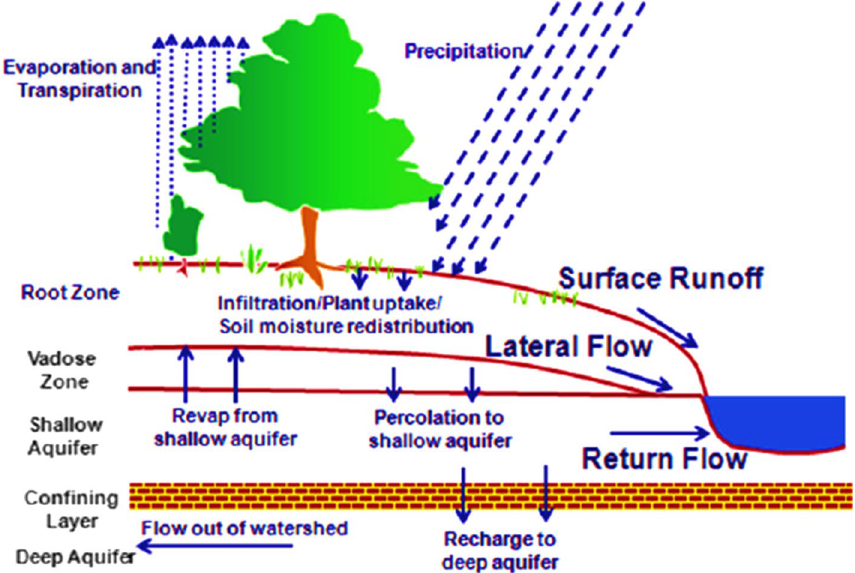
Fig. 2 Schematic representa- tion of the hydrologic cycle in SWAT model